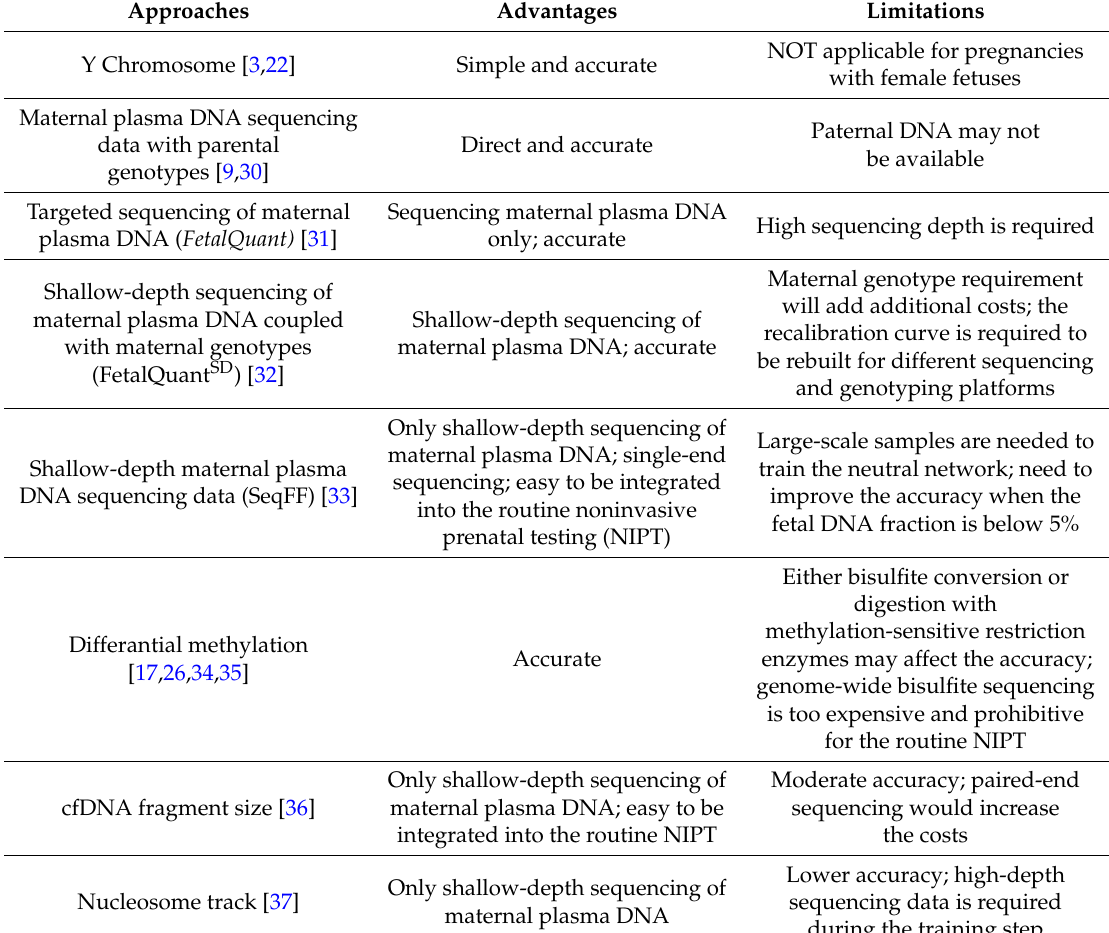
Table 1. The summary of current approaches for estimating fetal DNA